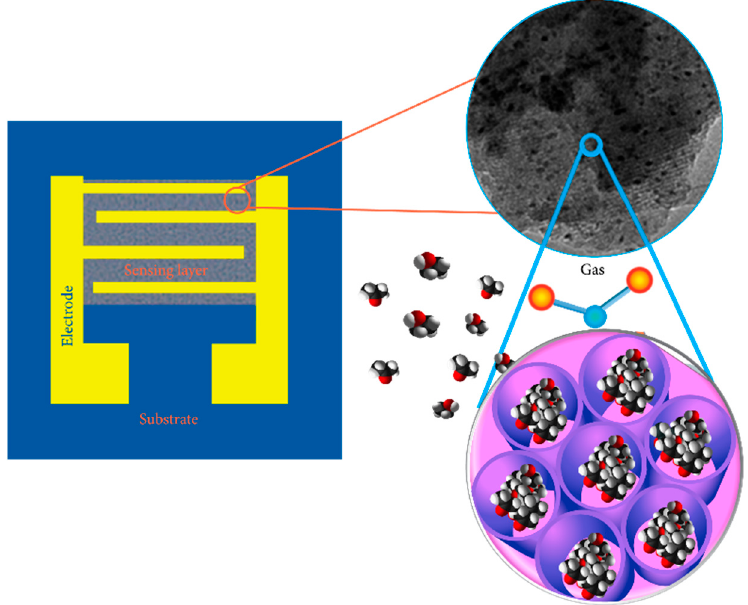
Figure 3. Schematic design of a gas sensor based on meso-nanoporous metal oxides. The device takes advantage from the porous structure and large specific surface area of the material to enhance the sensing performances. Reprinted under the terms of the Creative Commons Attribution License from Ref. [44].